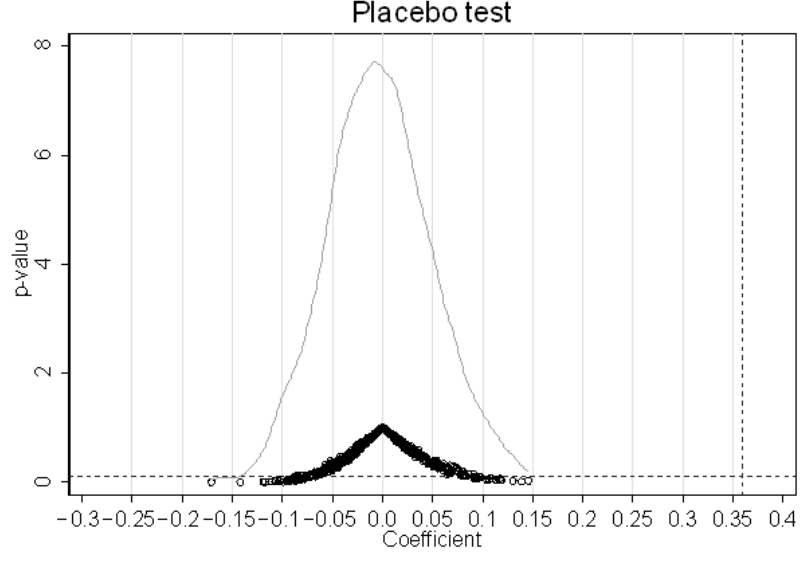
Figure 3. Placebo